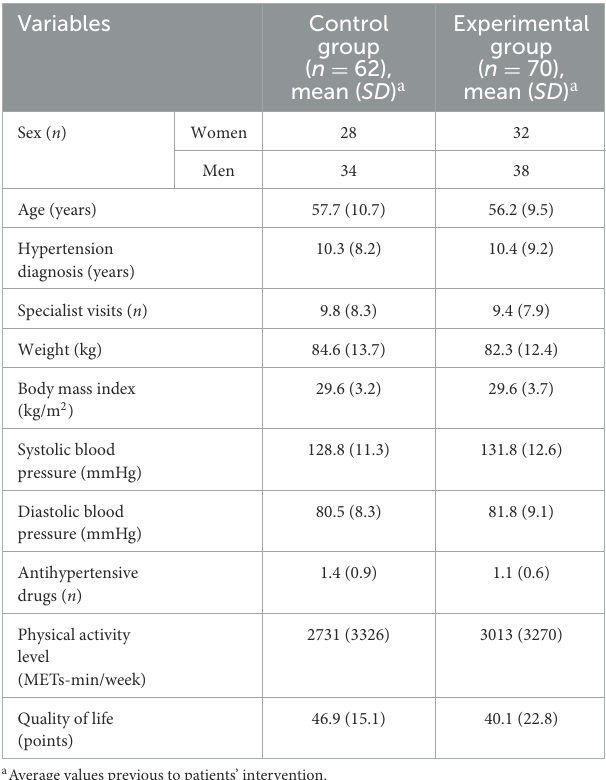
TABLE 1 Baseline characteristics of the